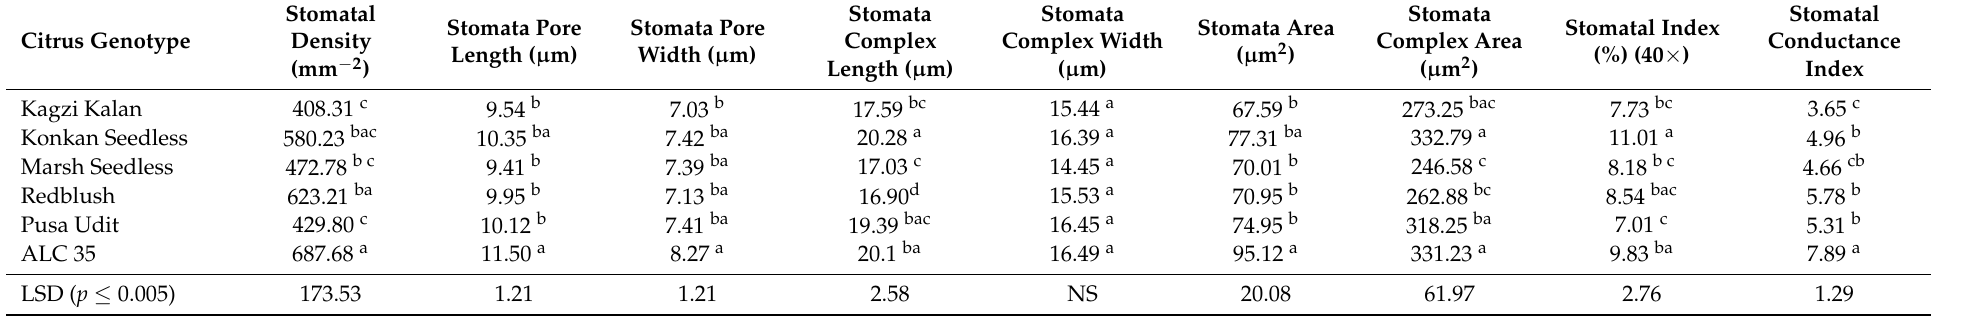
Table 2. Stomatal density and dimension of C itrus